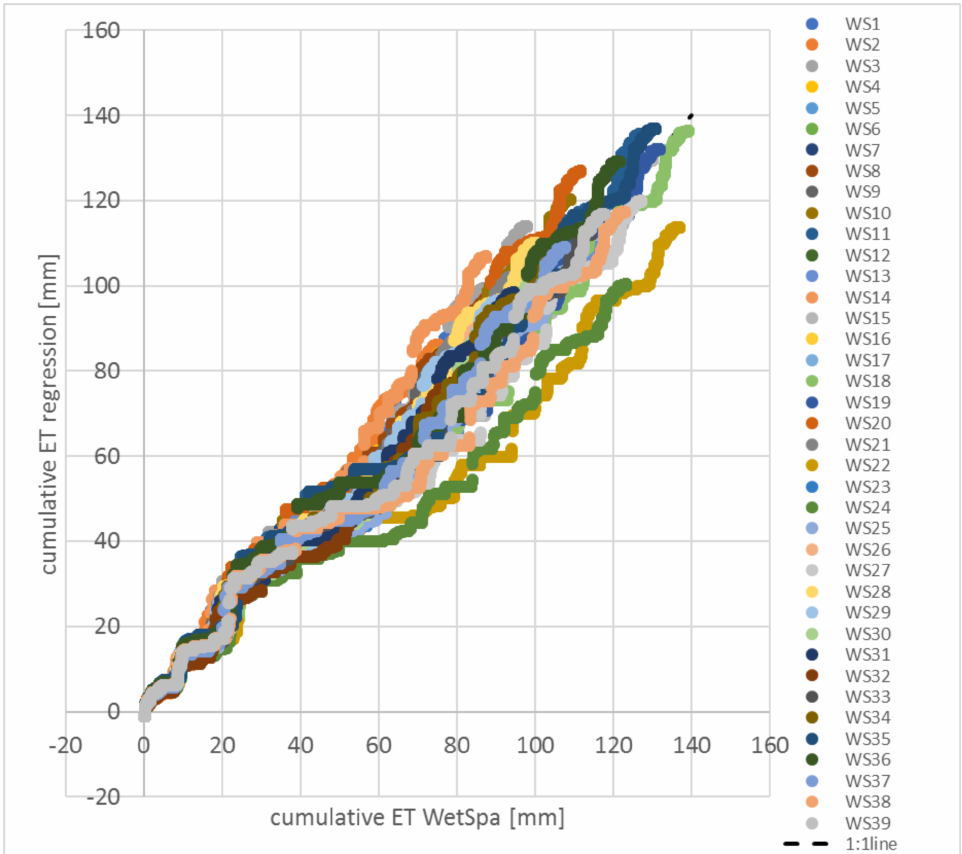
Figure 9. Cumulative ET: WetSpa simulation vs. regression for the 39 sub-catchments (WS) of the